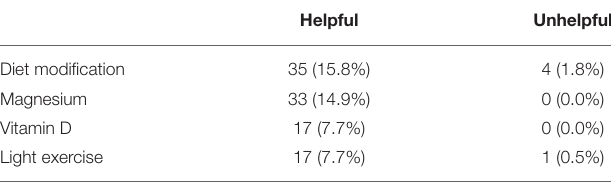
TABLE 3 | Four main categories observed in open-ended comments from MT and SO respondents (combined) regarding “Helpful” treatments/symptom management strategies expressed as raw numbers and